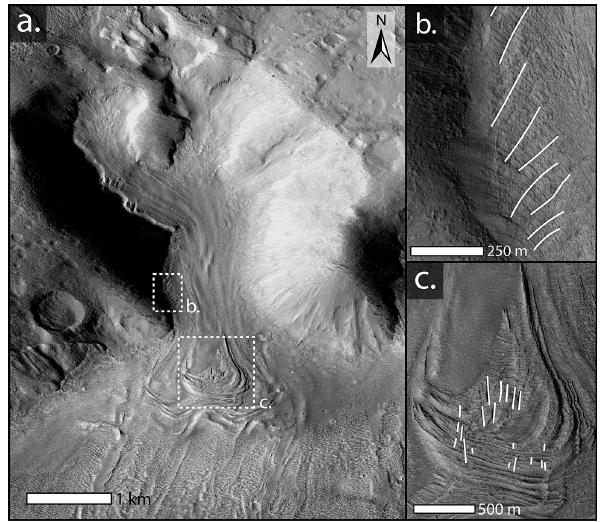
Figure 7. CTX image of crevassed GLF #541, located in Deuteronilus Mensae (Fig. 5b) (a) , along with expansions of two crevasse sets ( b and c